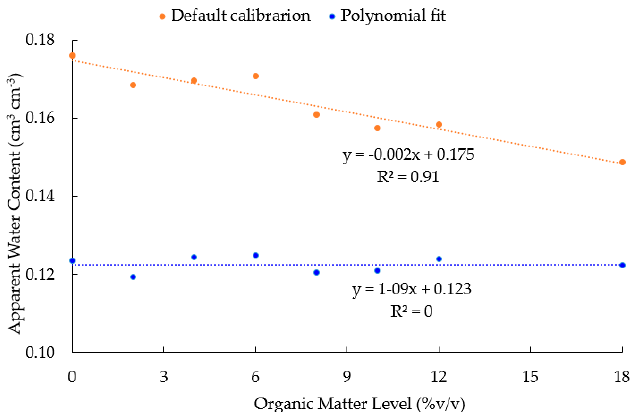
Figure 6. Correlation between organic matter level and apparent water content based on the default calibration (before correction) and the multivariate polynomial calibration equation (after correction). The multivariate polynomial calibration equation had a residual standard error of 0.014 cm 3 cm − 3 and a coefficient of determination ( R 2 ) of 0.98. Overall, the two approaches of